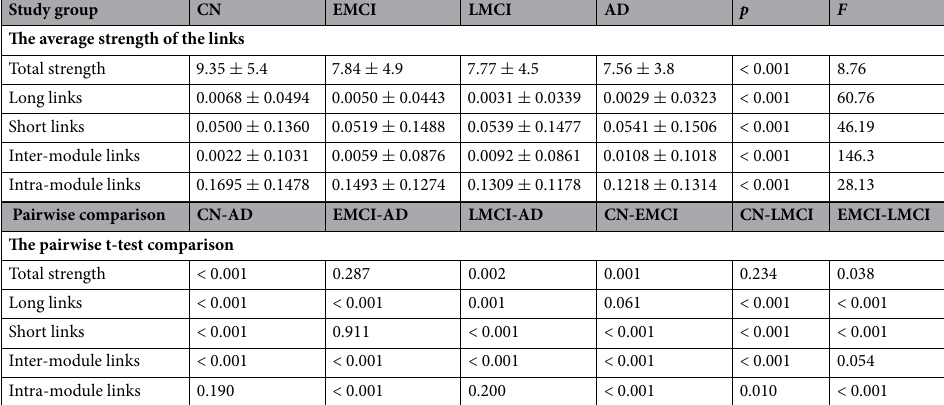
links were defined as the links that the euclidean distance between its vertices is smaller (larger) than the average distance among all vertices.). For each group network, the average weight of the long links and the average weight